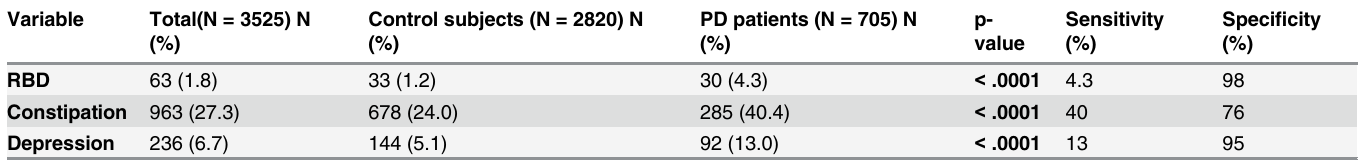
Table 2. Comparisons of depression/constipation/RBD distribution between study subjects with and without PD.